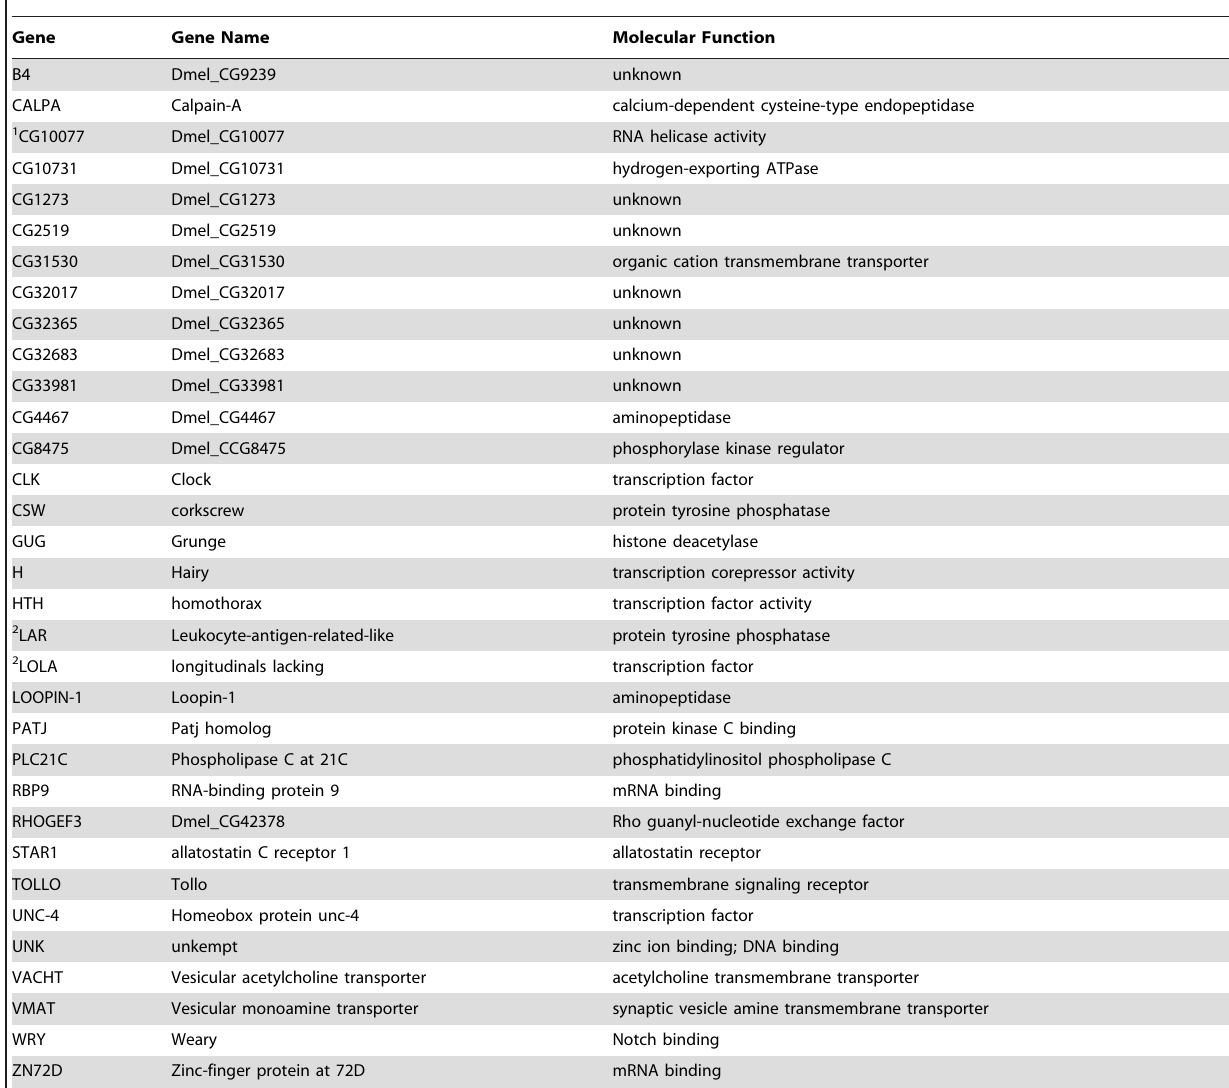
Table 2. Putative mRNA targets for co-regulation by miRs-8, -289, and -958 (miRBase).